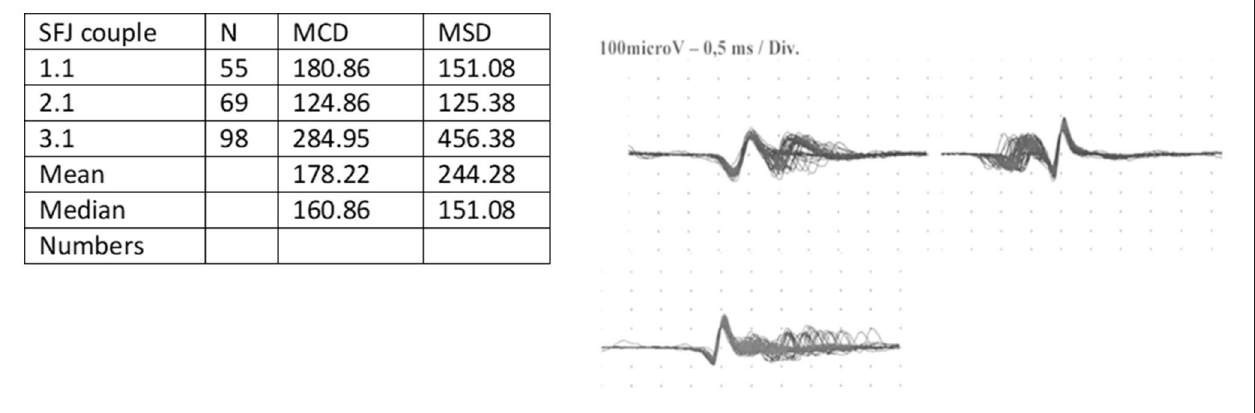
FIGURE 1 | SFEMG jitter by frontal muscle. SFEMG, single fiber electromyography; SFJ, single fiber